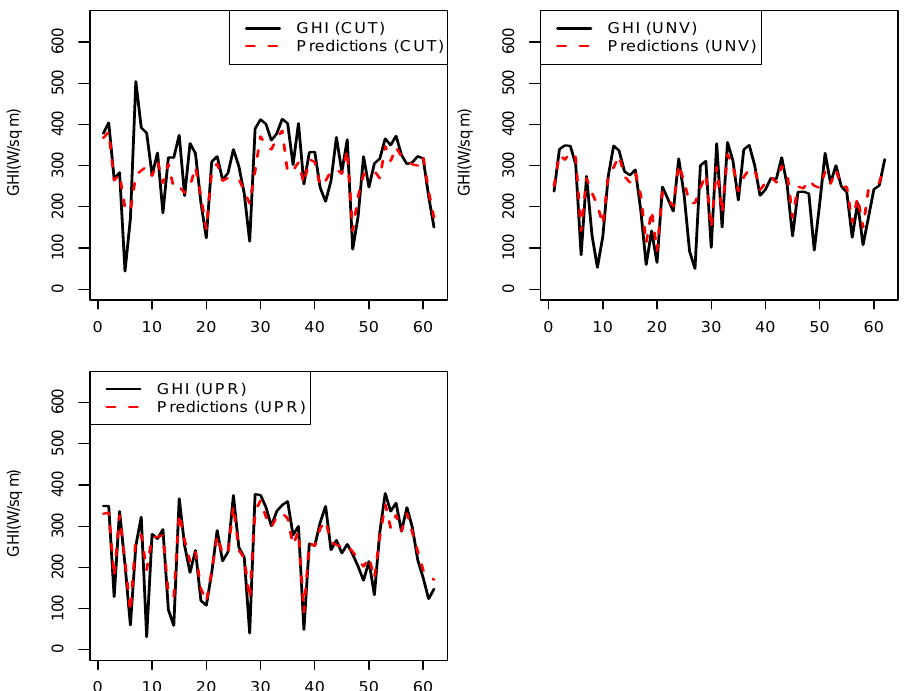
Figure 9. Predictions at CUT, UNV, and UPR radiometric stations. Kendall’s rank correlation coefficients were used to measure the association between the prediction errors shown in Figure 10. It shows pairwise scatter plots, the Kendall tau coefficients and the histograms. The computations of the Kendall tau coefficients show that errors for stations CUT, UNV and UPR are close to zero except between CUT and UPR, which is 0.17.